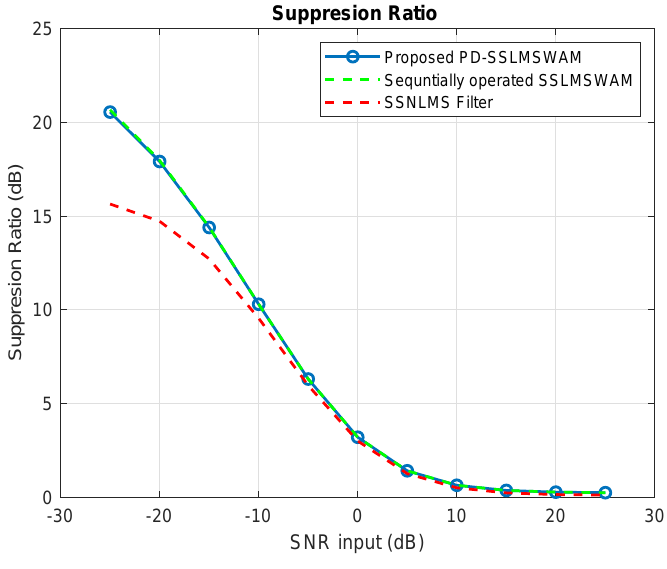
Figure 14. Suppression